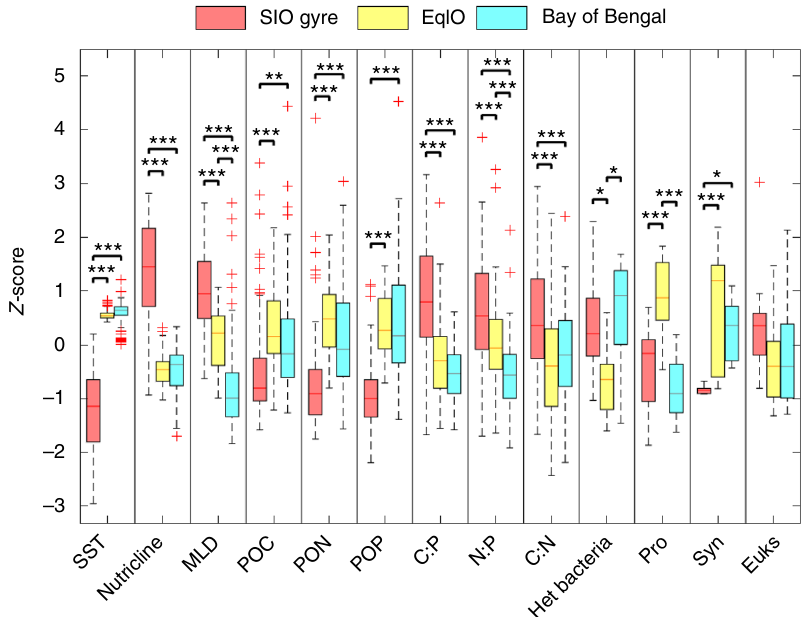
Fig. 4 Regional variation in environmental parameters, relative biomass, and POM concentrations and ratios. Signi fi cant regional variation between speci fi c regions is indicated by the number of stars (ANOVA, * p < 0.5, ** p < 0.01, *** p < 0.001). For relative biomass; Het bacteria = heterotrophic bacteria, Pro = Prochlorococcus , Syn = Synechococcus , and Euks =